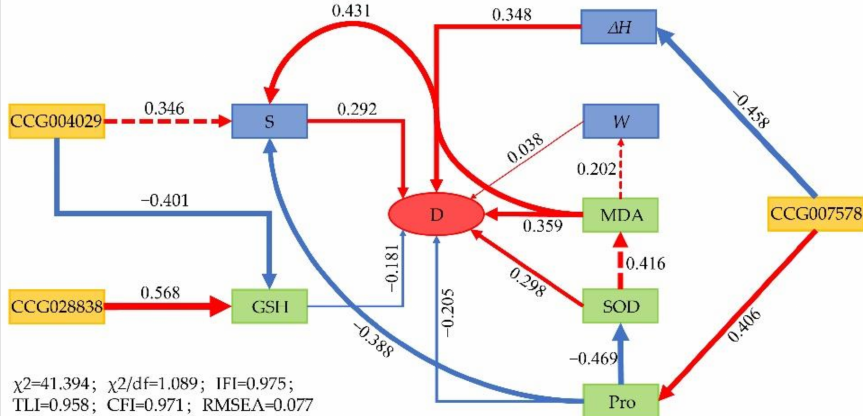
Figure 6. Growth, morphology, and physiological and biochemical indices, and relationship between the NAC genes and D value in various drought-resistant C. equisetifolia families. The number on arrows is the standardized path coefficient. Arrow width indicates path strength. Positive and negative path coefficients of arrows are displayed in red and blue, respectively. Solid line represents a path with a significance level p < 0.05. Dotted line represents a path without